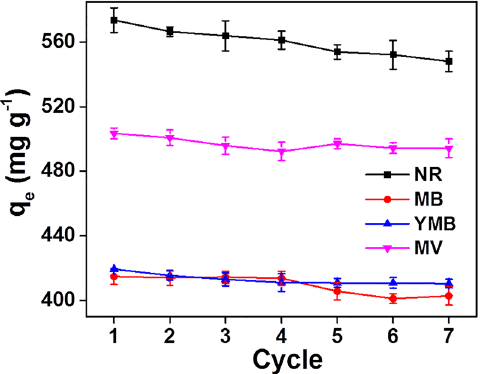
Figure 5. The regeneration of PAAM/PA/PDA hydrogel.